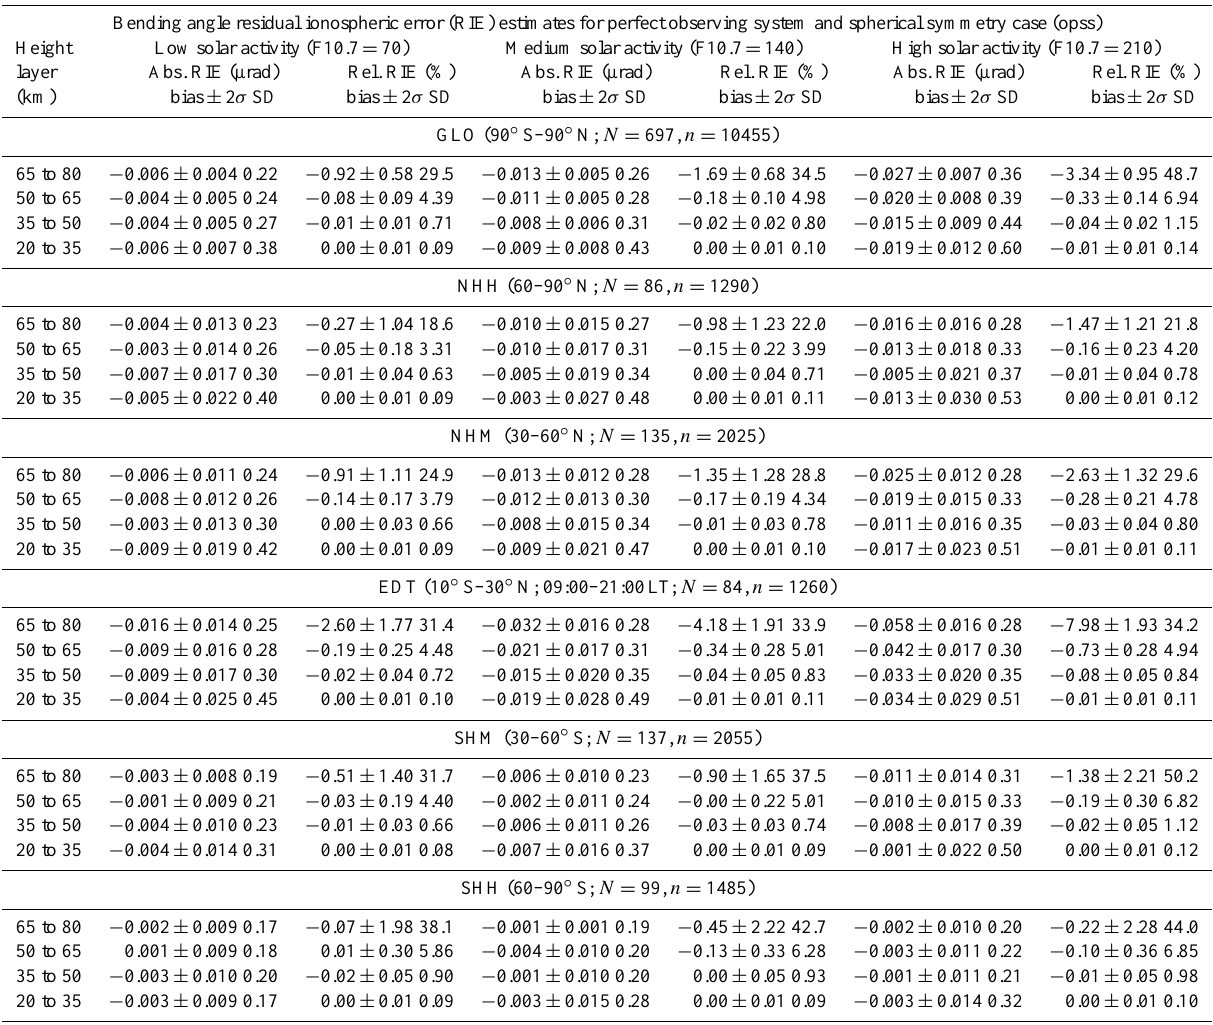
Table 4. Absolute and relative biases (means), including their 2 σ (95%) confidence range, and absolute and relative standard deviations of bending angle RIEs of the six geographic zones (cf. Table 2) in four impact height layers (upper mesosphere, 65–80km; lower mesosphere, 50–65km; upper stratosphere, 35–50km; lower stratosphere, 20–35km) at three solar activity levels, estimated from the opss data sets (f70opss, f140opss, f210opss) with the opwi data set as reference. Bending angle residual ionospheric error (RIE) estimates for perfect observing system and spherical symmetry case (opss)